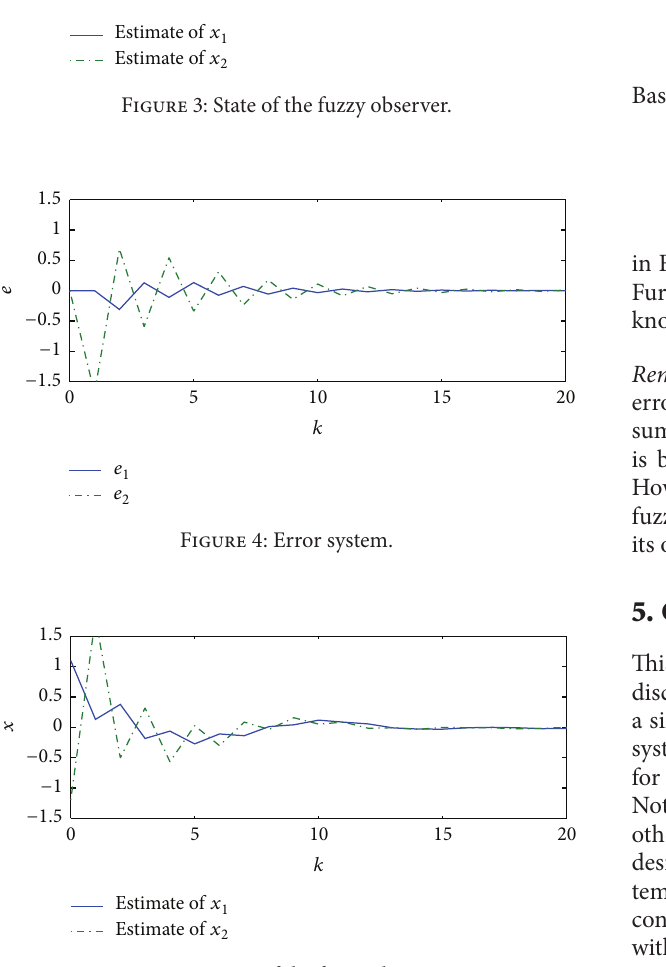
Figure 5: State of the fuzzy observer.